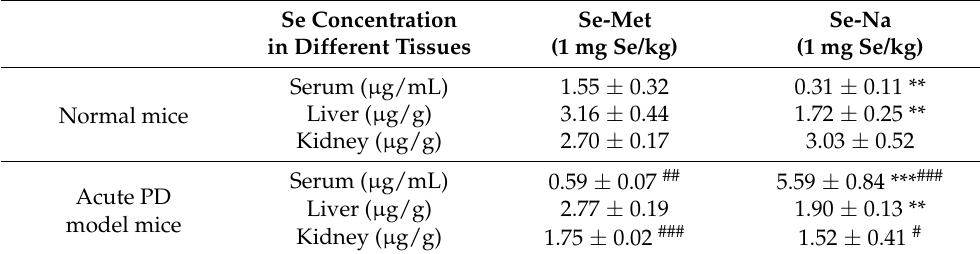
Values are expressed as mean ± SD, n = 3. ** p < 0.01, *** p < 0.001 vs. Se-Met treated normal or acute PD mice; # p < 0.05, ## p < 0.01, ### p < 0.001 vs. normal mice treated by Se-Met or Se-Na. PD, Parkinson’s disease; Se, selenium; Se-Na, sodium selenite; Se-Met, seleno-L-methionine. Se-Met and Se-Na were fed to normal or acute PD model mice via oral gavage at the same Se dose (1 mg Se/kg) for 24 h followed by collection of different tissues for Se concentration